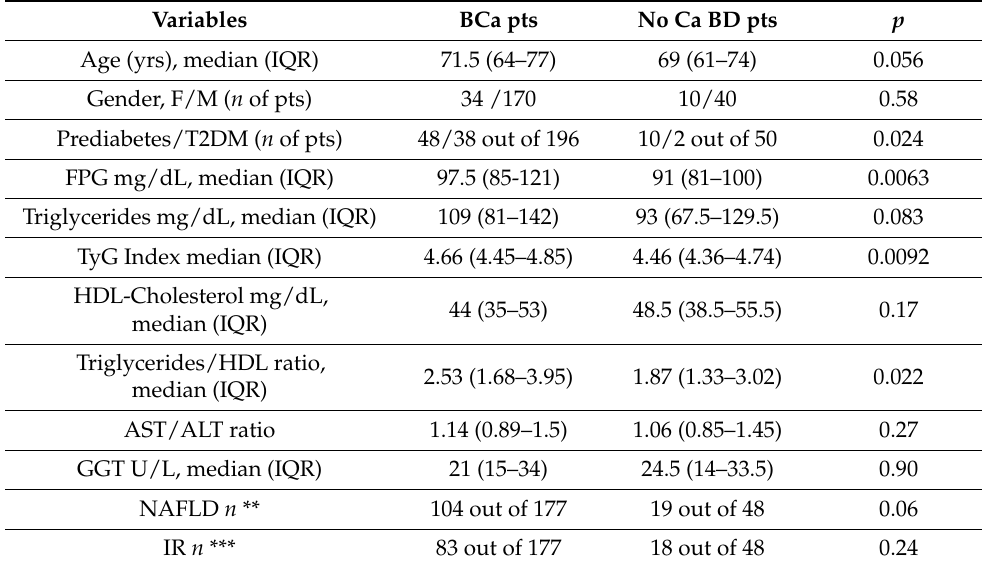
Table 1. Demographic characteristics, comorbidities and studied parameters of the two groups.